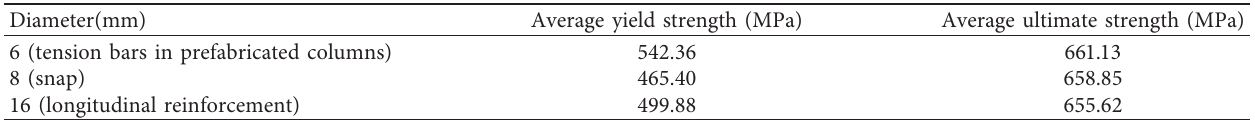
Figure 4: Assemblage and grouting of a column-base joint. (a) Chiseled joint surface on the base beam. (b) Chiseled joint surface on the column. (c) Assemblage of column onto the base beam. (d) Pressure grouting. Table 3: Mechanical parameters of the reinforcing bar.